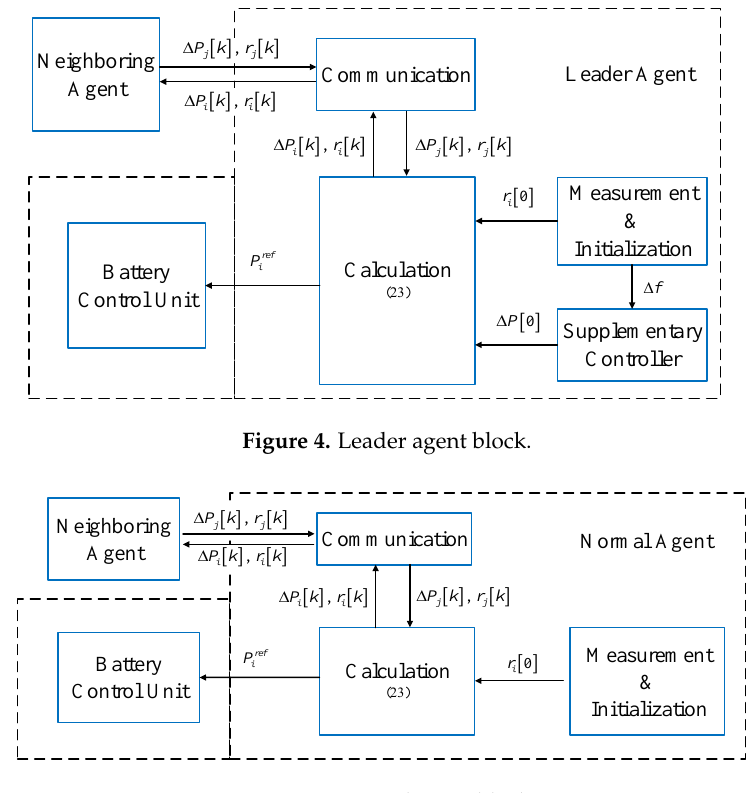
Figure 5. Normal agent